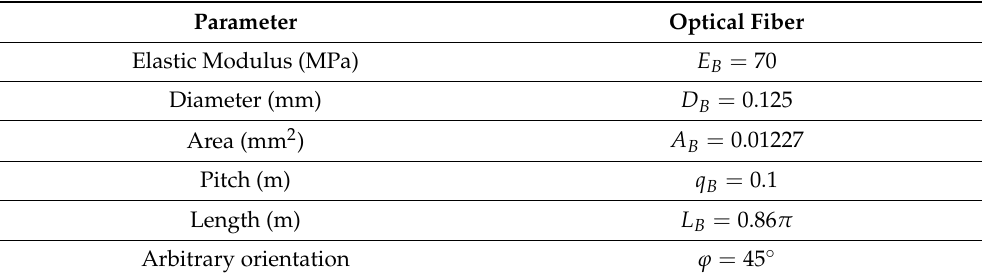
Figure 11. The Theory of FBG Strain Sensor Array ( a ) FBG distributed sensors installed in the pipeline ( b ) The relationship between the pipe hoop strain ε H and the fiber grating strain ε B . Table 3. Fiber-optic parameters.